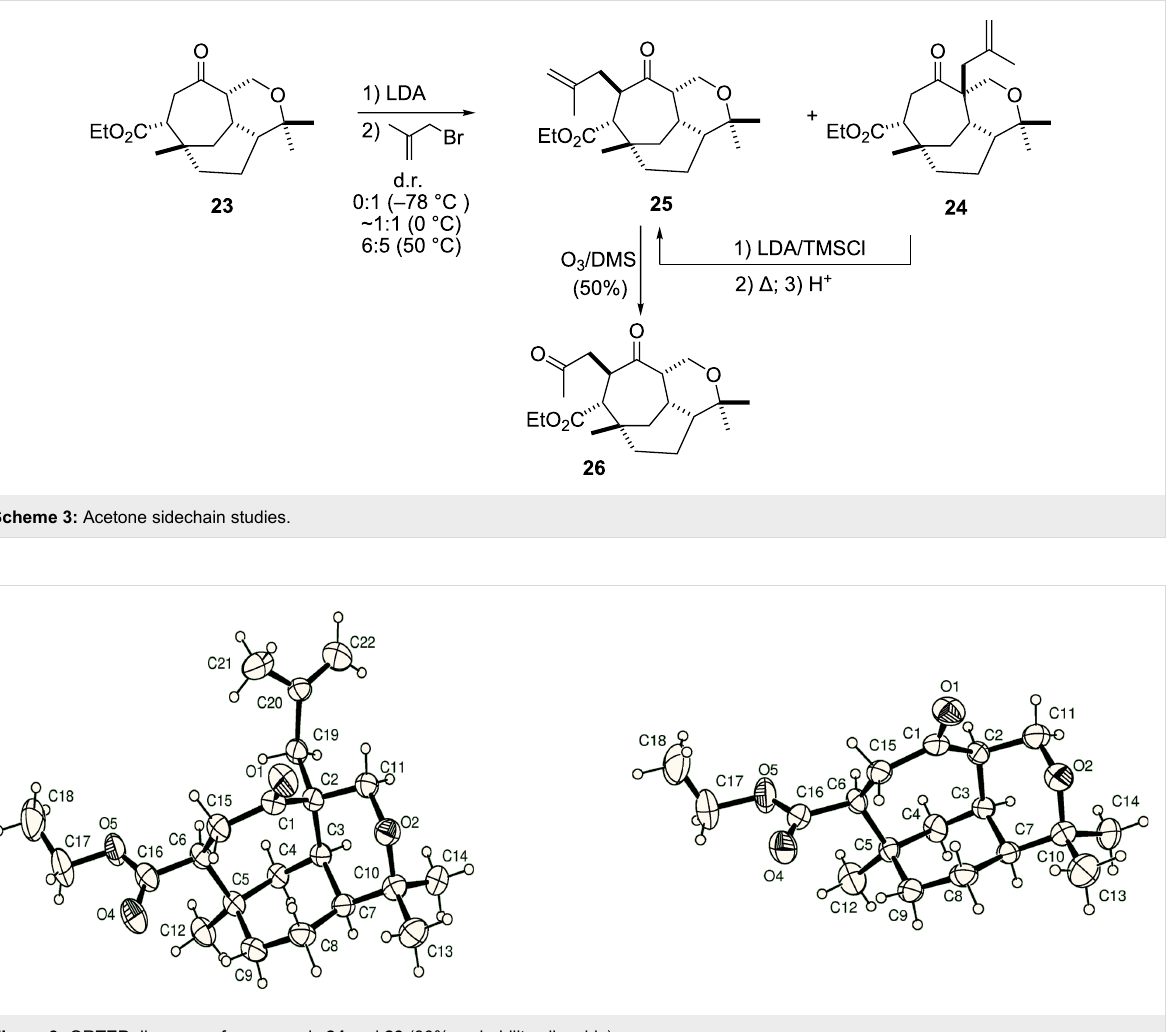
Figure 3: ORTEP diagrams of compounds 24 and 23 (30% probability